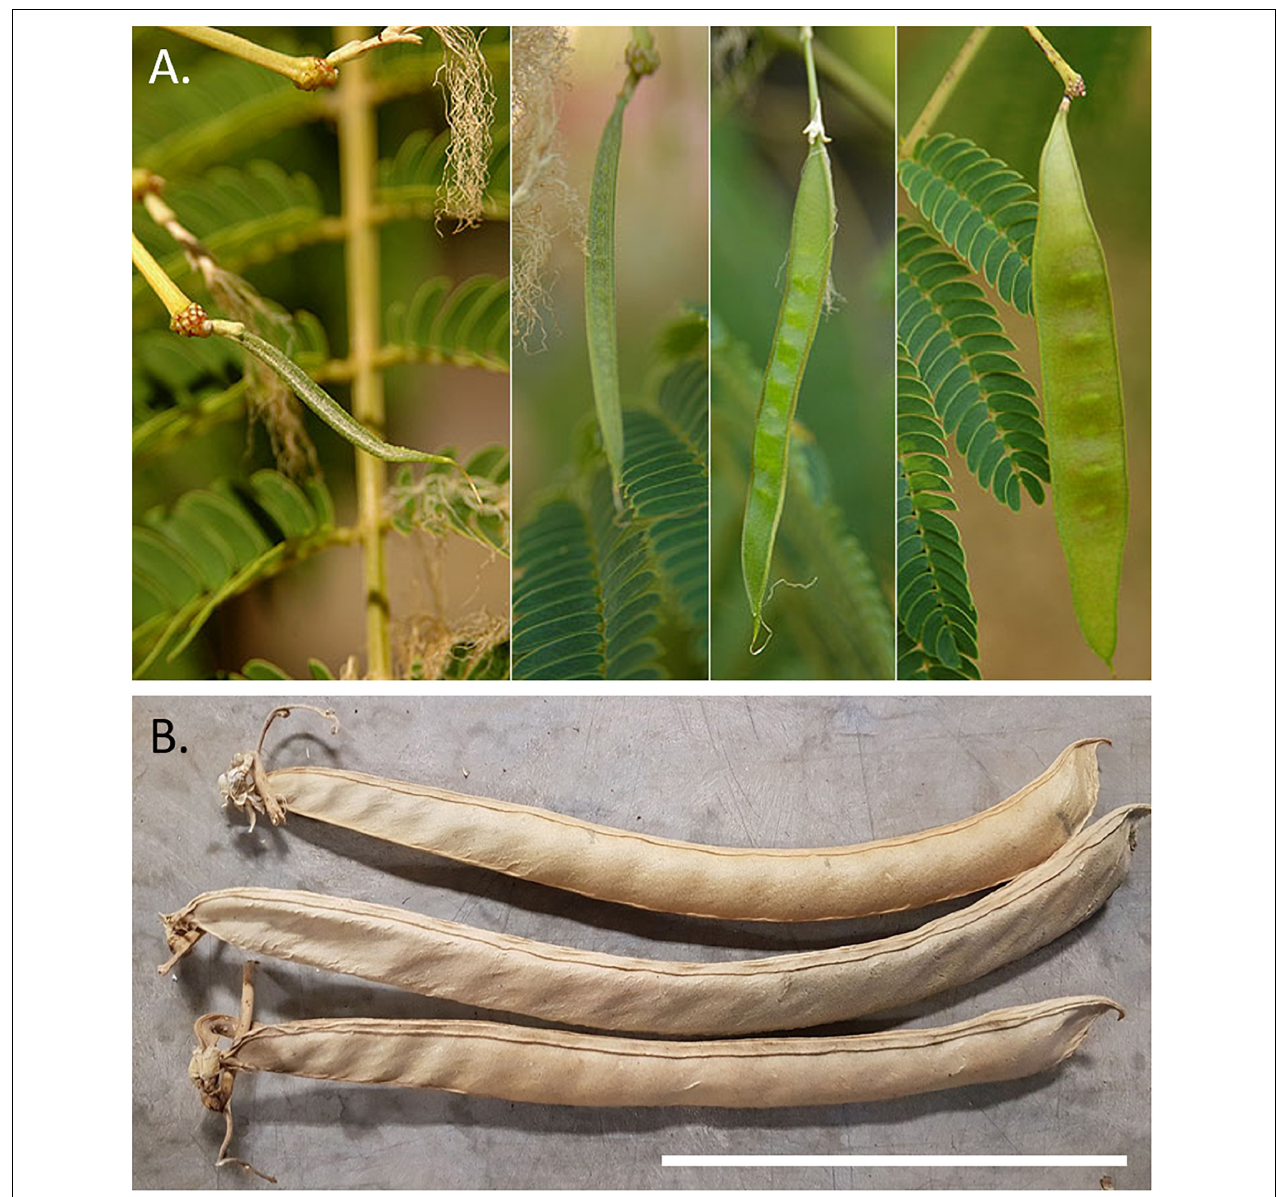
FIGURE 3 | Possible species contributing the large legume pods found in the Loggia of Cupid and Psyche in the Villa Farnesina. (A) Silk tree ( Albizia julibrissin ) pods showing different stages of development. Photo: P. Breen, Landscape Plants, Oregon State University. (https://landscapeplants.oregonstate.edu/plants/ albizia-julibrissin). (B) Dry pods of Sword Bean ( Canavalia gladiata ). Photo: J. R. Myers. Size bar = 10